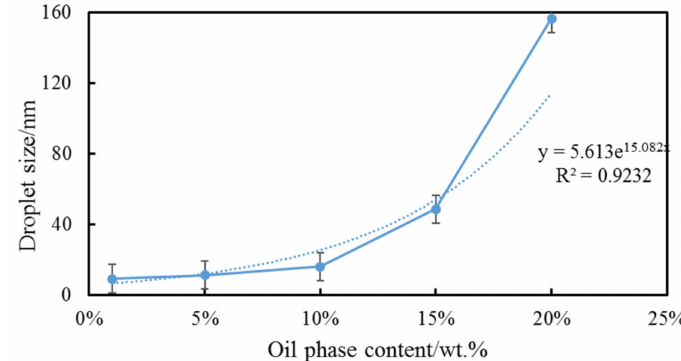
Figure 7. Nanoemulsions with different droplet